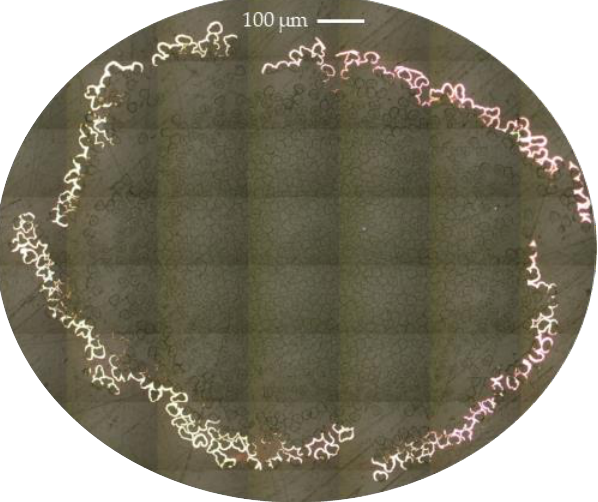
Figure 3. Cross-section of coated tows (CRCF). The copper is visible as bright lines on the perimeter of the tows.